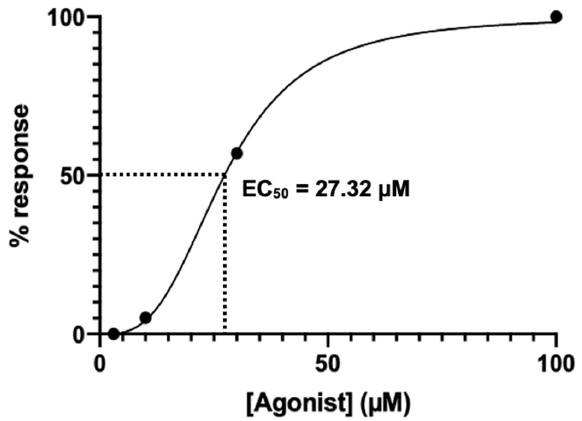
Figure A2. EC 50 of NTB assessed by NKCCA. The EC 50 of NTB was determined using flow cytometric cell lysis assays where NK cells isolated from HCs were treated with NTB (0, 3, 10, 30, 100 µM) and IL-2 (20 IU/mL) for 24 h to activate TRPM7 before incubating with K562 ( n = 4). Statistical analysis determined the EC 50 of NTB under these conditions to be 27.32 µM and is consistent with the